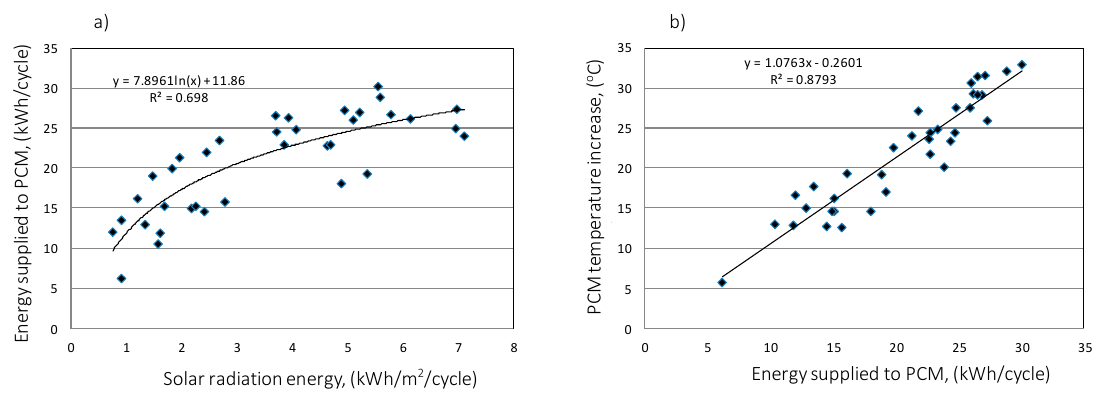
Figure 29. Energy stored in the accumulating bed depending on the duration of the charge cycle ( a ). Exhaust air enthalpy depending on the air enthalpy at the inlet of PCM accumulator ( b ).